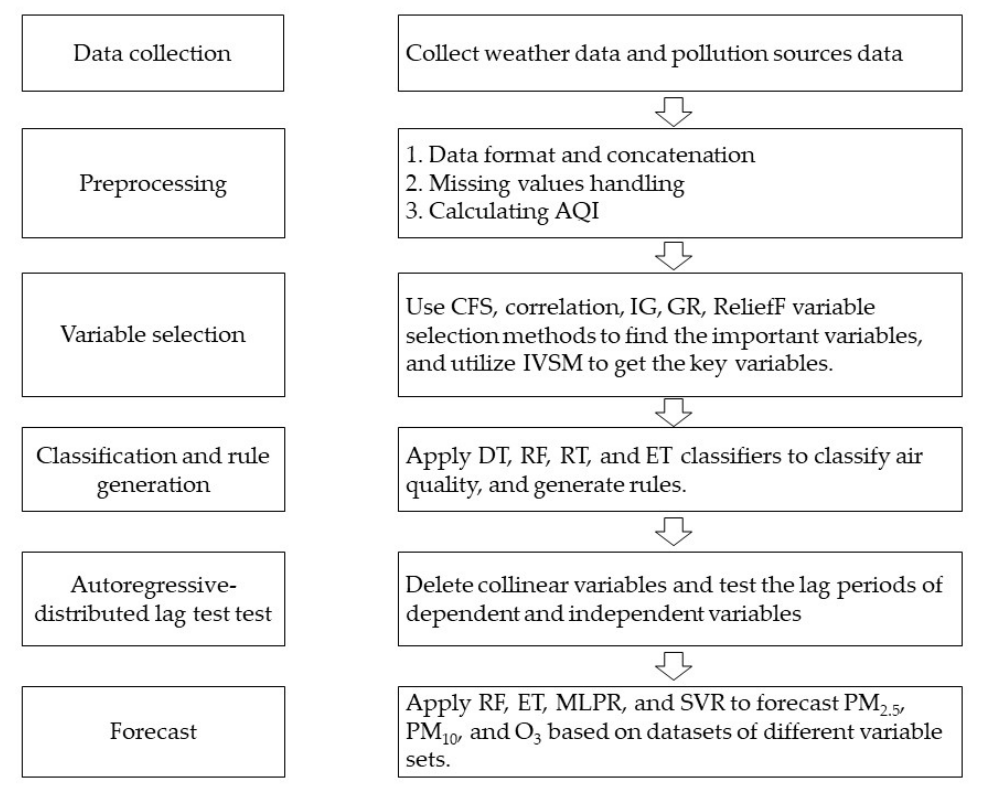
Figure 1. Computational procedure.